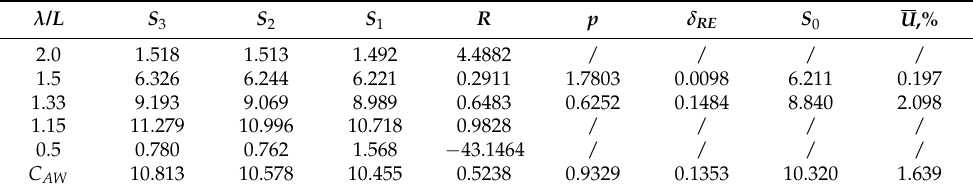
Table 3. Results of the verification study for panel size used to discretize KCS